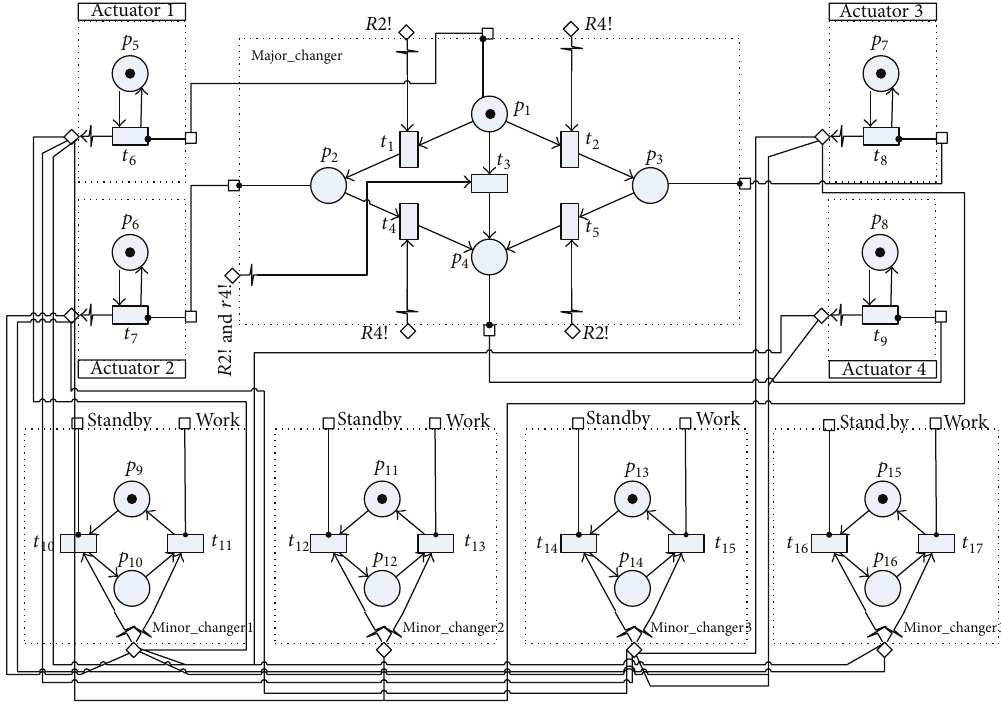
Figure 9: Control module of eRN AAS